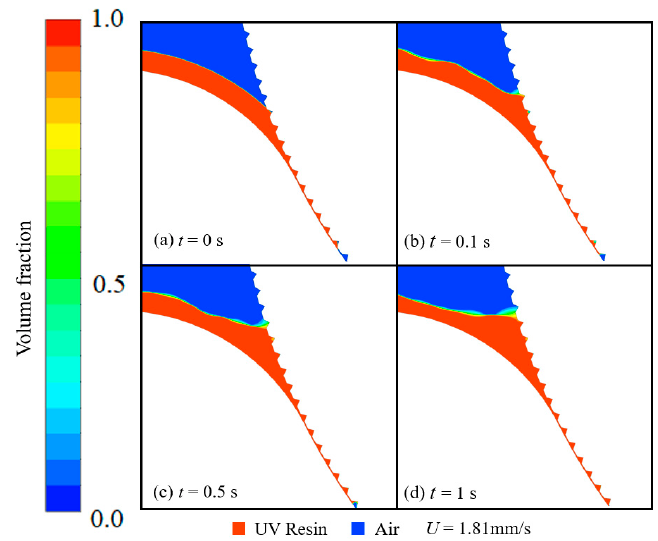
Figure 12. UV resin complete filling into V-shape patterns at the two ends of the roller mold at a PET web speed of 1.81 mm / s ( θ R = 20 ◦ , θ P = 55.7 ◦ ).